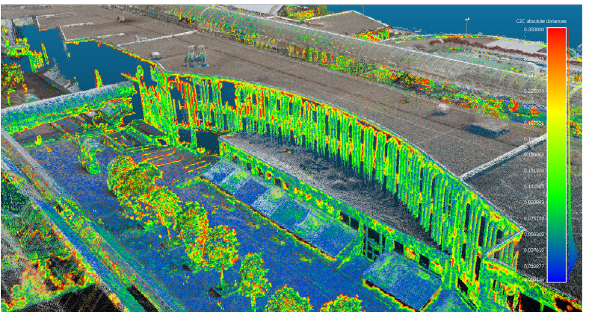
Figure 18. UAV/TIMMS main rear view cloud deviation